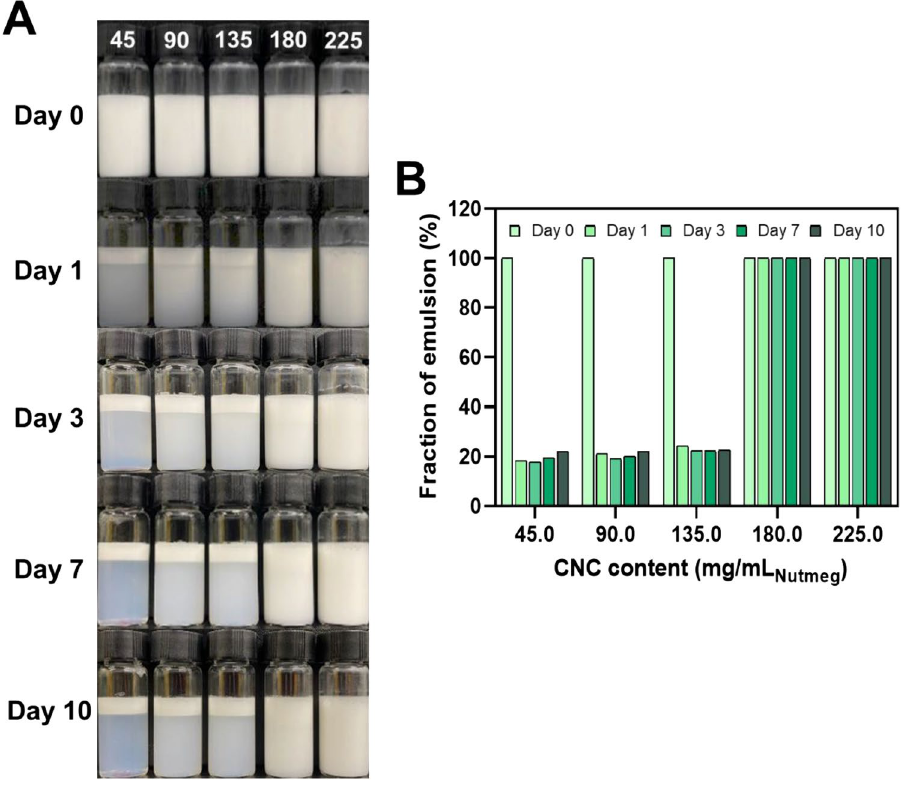
Figure 3. Phase separation of CNC/nutmeg PE solutions at different CNC content and storage time. ( A ) Digital images of PE solution and ( B ) the fraction of emulsion stored for 10